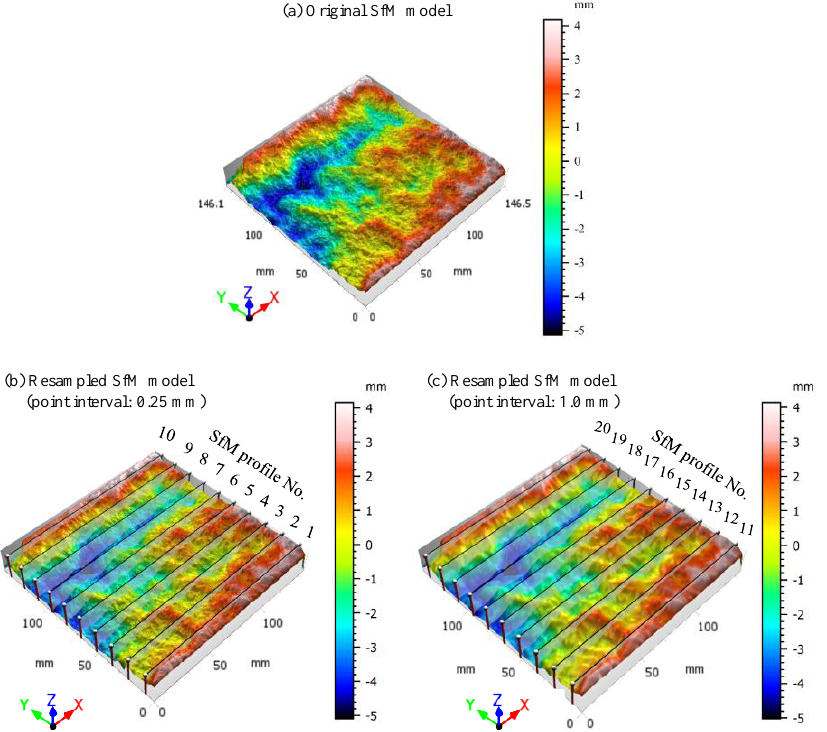
Figure 12. SfM models of RJ1 generated by Pixel 2 with a shooting angle 60°, ( a ) original SfM model, ( b ) and ( c ) resampled SfM models with point interval 0.25 and 1.0 mm, respectively.